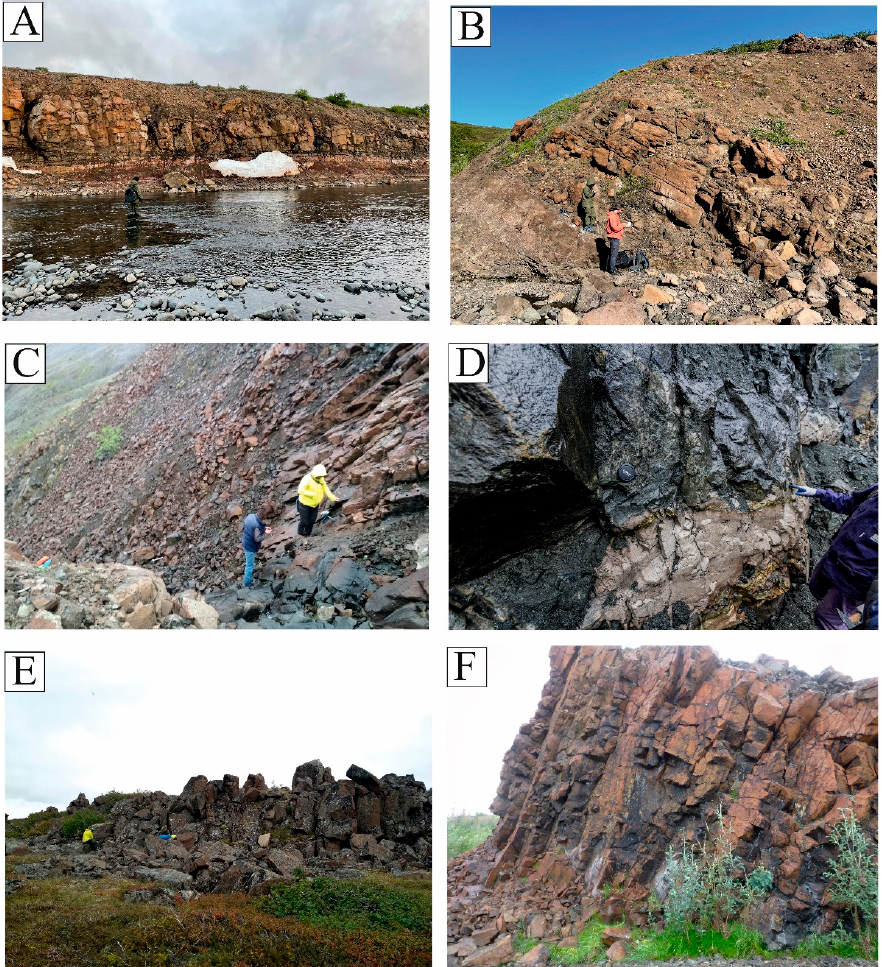
Figure 2. ( A ) Basaltic lava flow of the Samoedsky Formation, the Verkhnyaya Talovaya river; site sm22_21. ( B ) Basaltic lava flow of the Kharaelakhsky Formation, the Mokulay section; site kh24_21. ( C ) Intrusion of Zayachiy Creek, the Listvyanka gorge; site RZ1. ( D ) Hornfels from the bottom of the Noril’sk-1 intrusion, the open pit “Medvezhiy Creek”; site 14.2_17. ( E ) The Arylakh intrusion, Icon trough; site AR3. ( F ) Sill of the Yergalakhsky complex, the Imangda river; site I6. The Icon area is located 150 km NE of Noril’sk, within the Icon trough. The Arylakh layered intrusion (Figure 2E) with weak mineralization (the Noril’sk type) was sampled